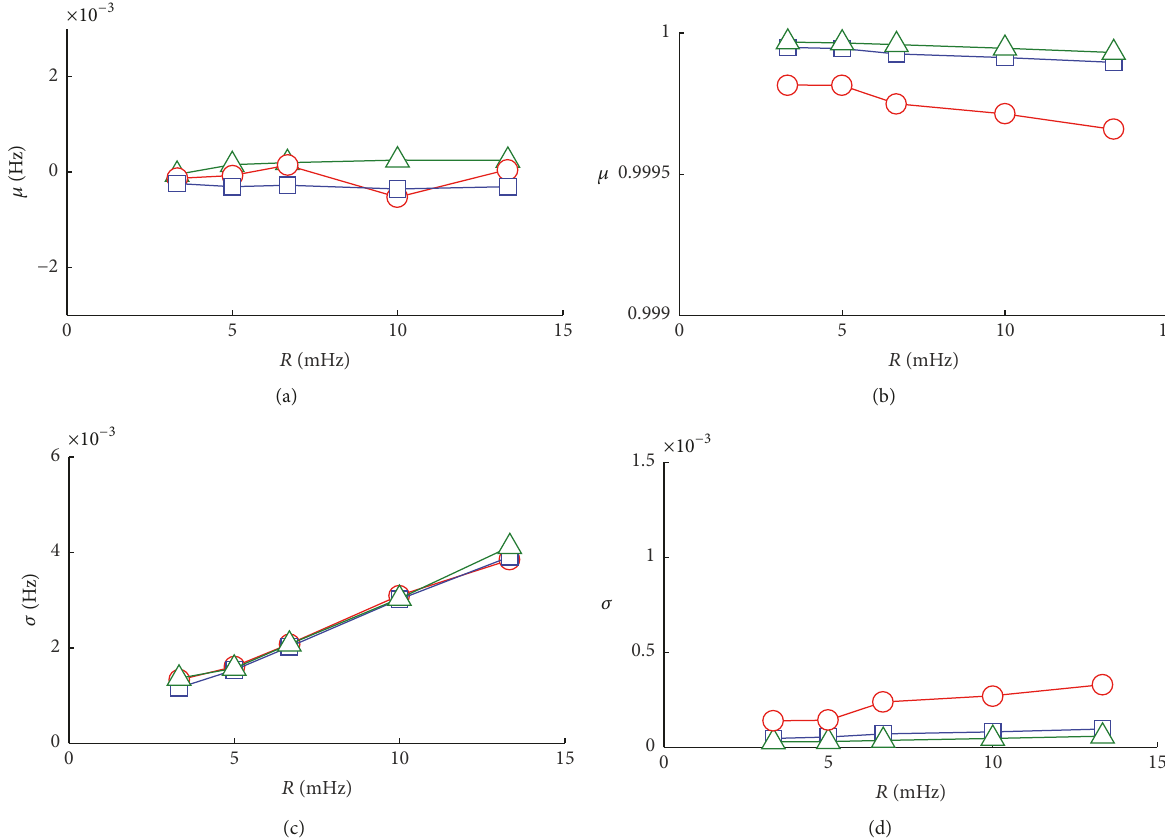
this, an automated data check procedure was also